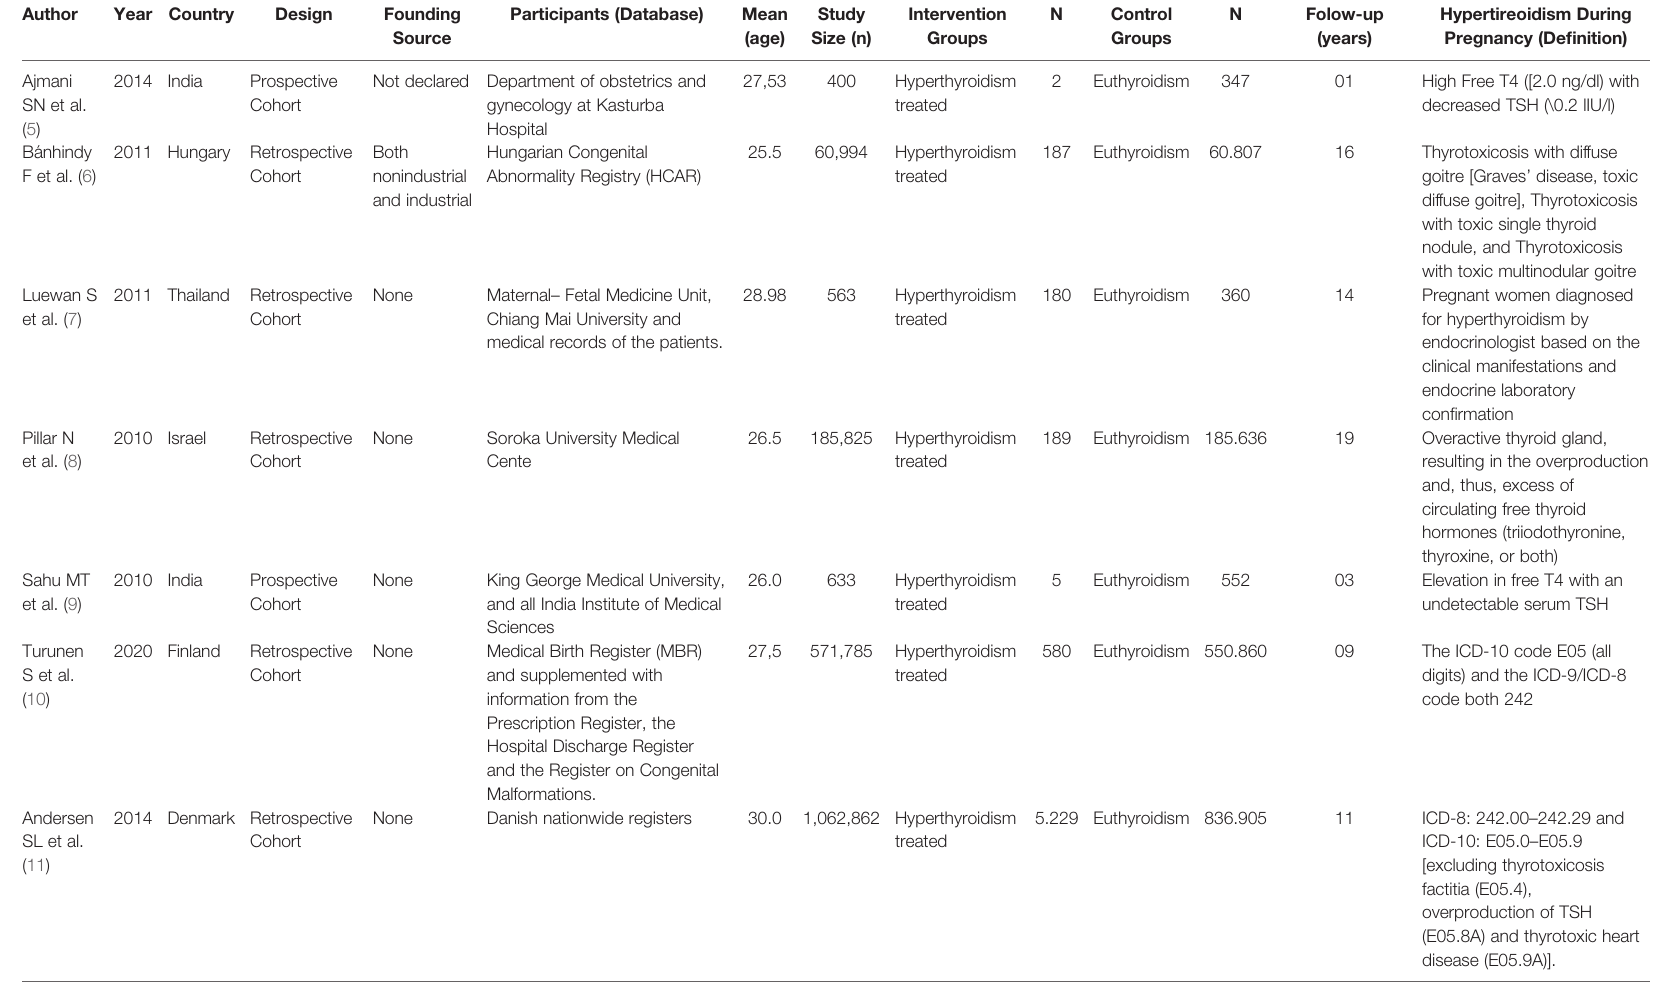
TABLE 1 | Newcastle-Ottawa quality assessment